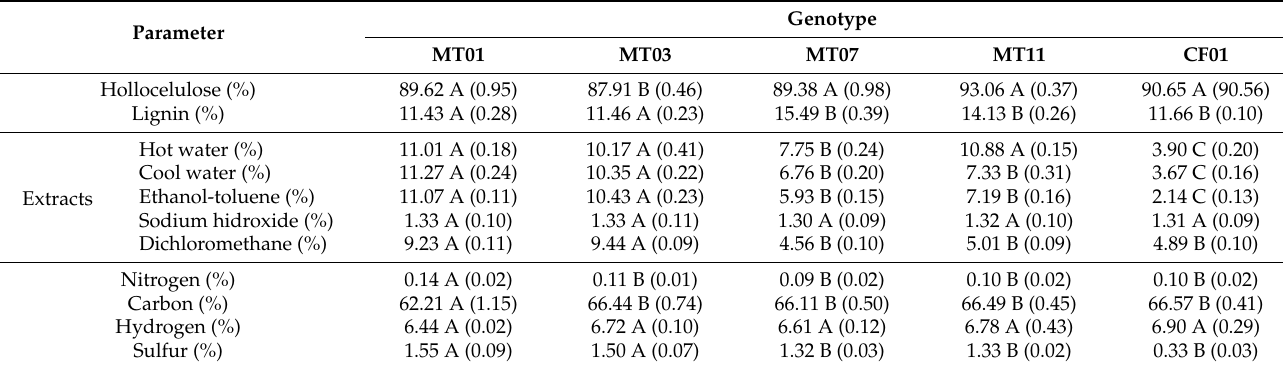
Table 2. Fiber chemical properties for five genotypes of M. textilis